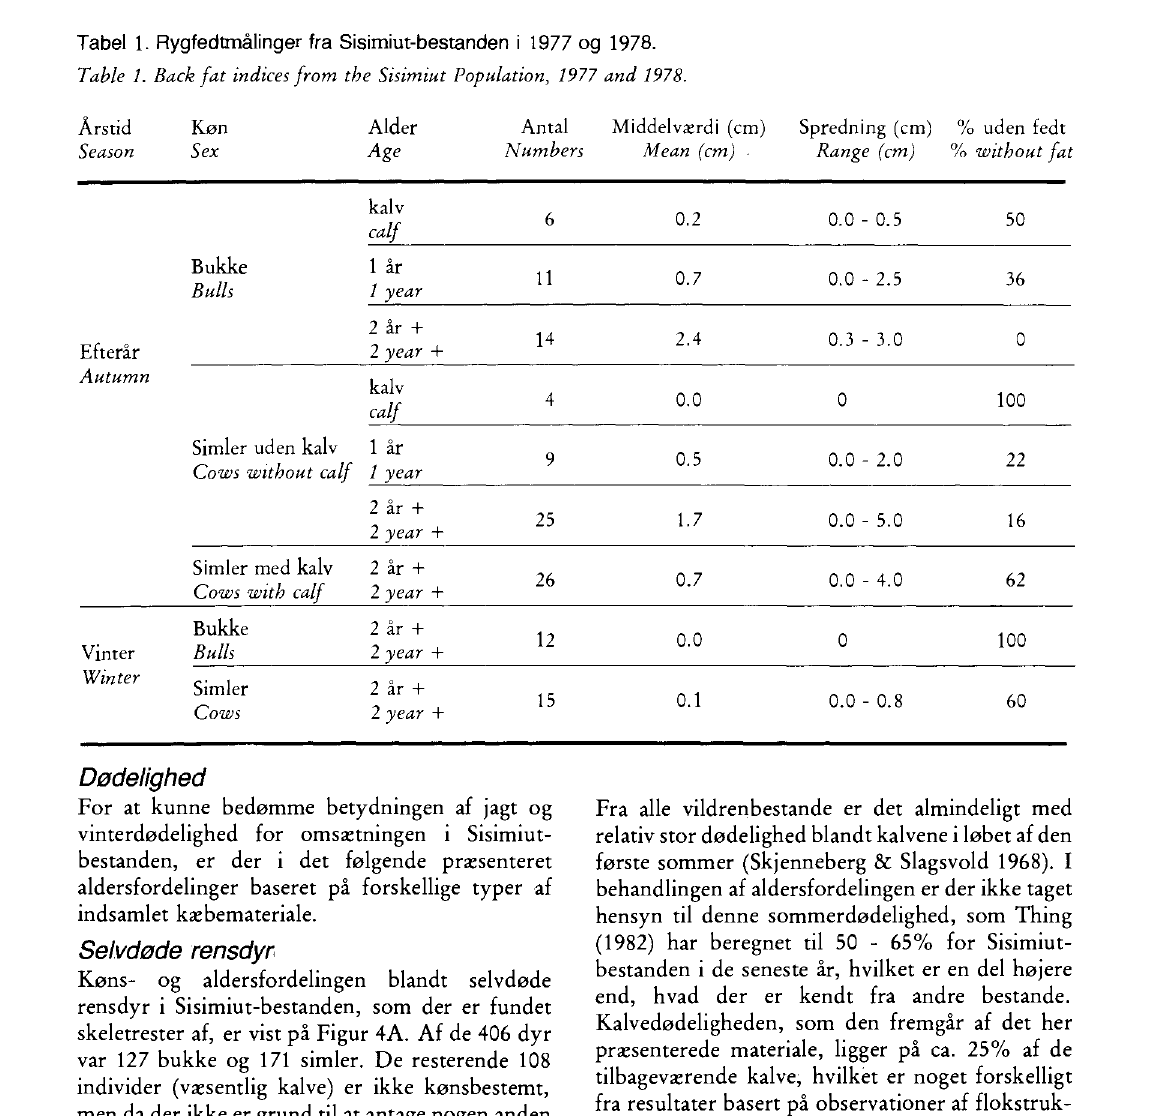
Table 1. Back fat indices from the Sisimiut Population, 1977 and 1978. Årstid Alder Antal Middelværdi (cm) Spredning (cm) % uden fedt Season Age Numbers Mean (cm) • Range (cm) % without